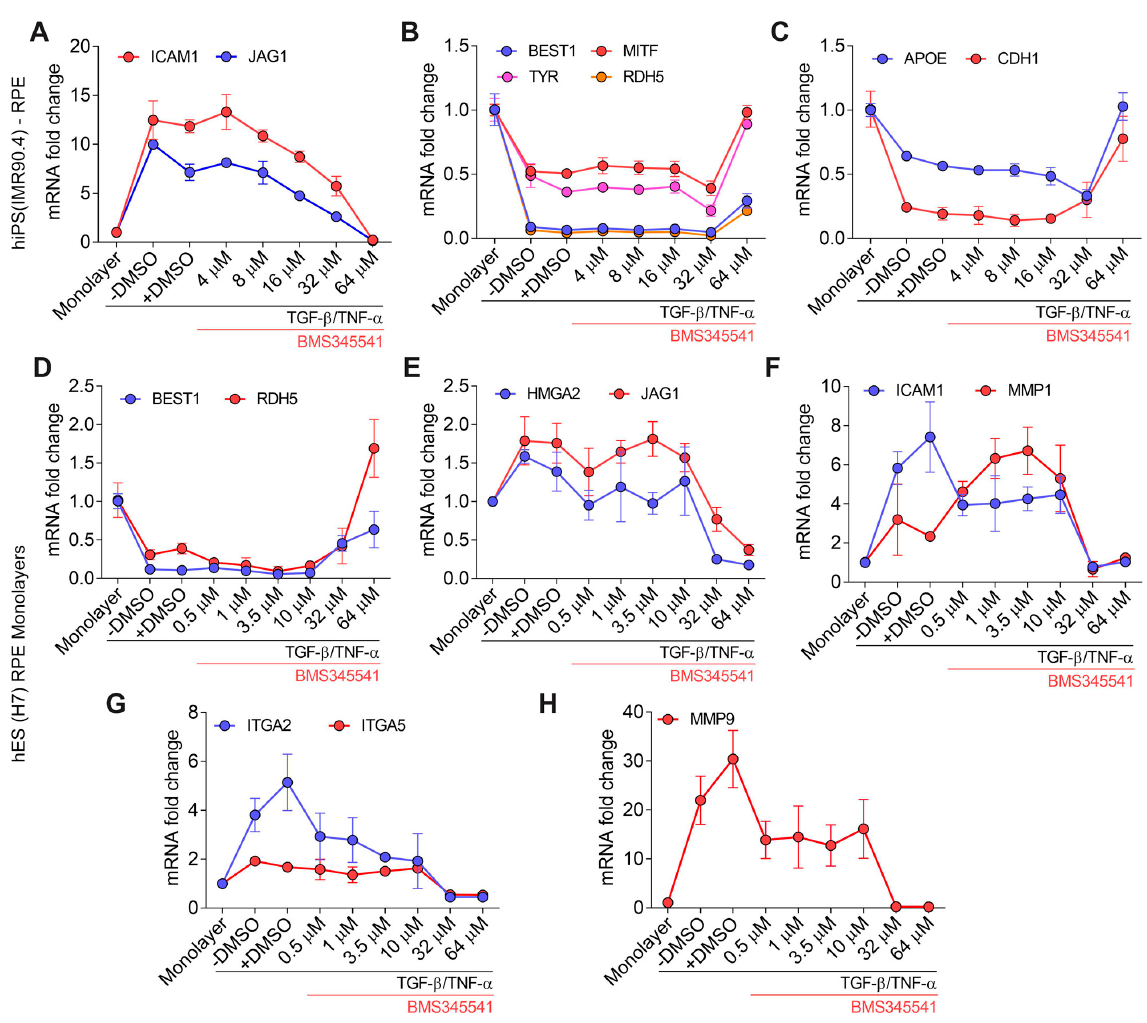
Figure 5. qPCR validation of TGF– β /TNF– α -induced RPE–EMT by IKK β inhibitor BMS345541. ( A – C ) Differential expression of RPE-EMT-associated factors were measured after treatment with BMS345541 in TGF– β /TNF– α -induced EMT in hiPS (IMR90.4) RPE. ( D – H ). Differential expression of RPE–EMT-associated factors were measured after treatment with BMS345541 in TGF– β /TNF– α - induced EMT in hES (H7)